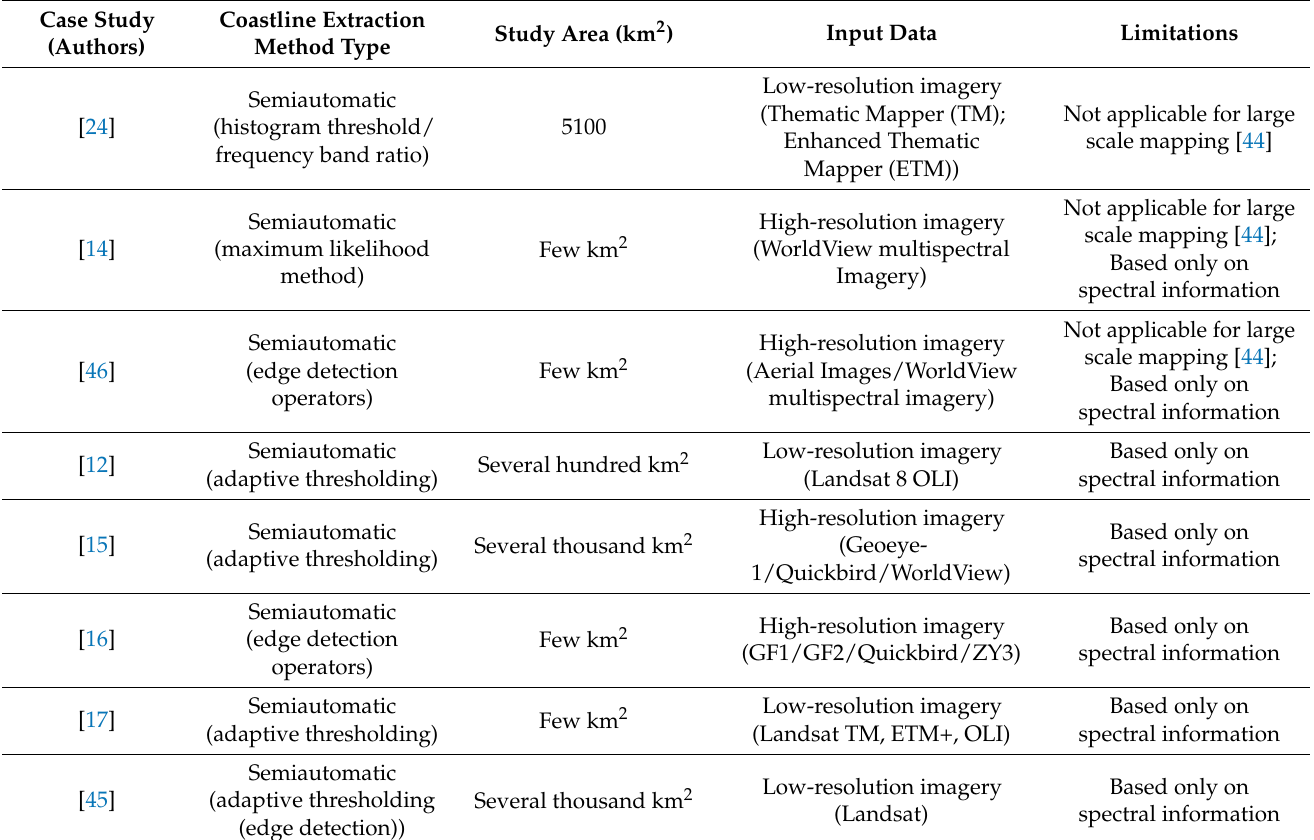
Table 1. Review of various existing remote sensing coastline extraction